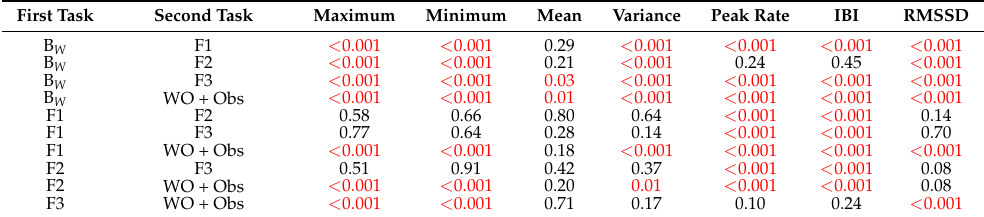
Table 7. Kruskal Wallis p -values: comparison between tasks in young adults. The values high- lighted in red refer to p -value lower than the significance level chosen: α = 0.05. The analyzed